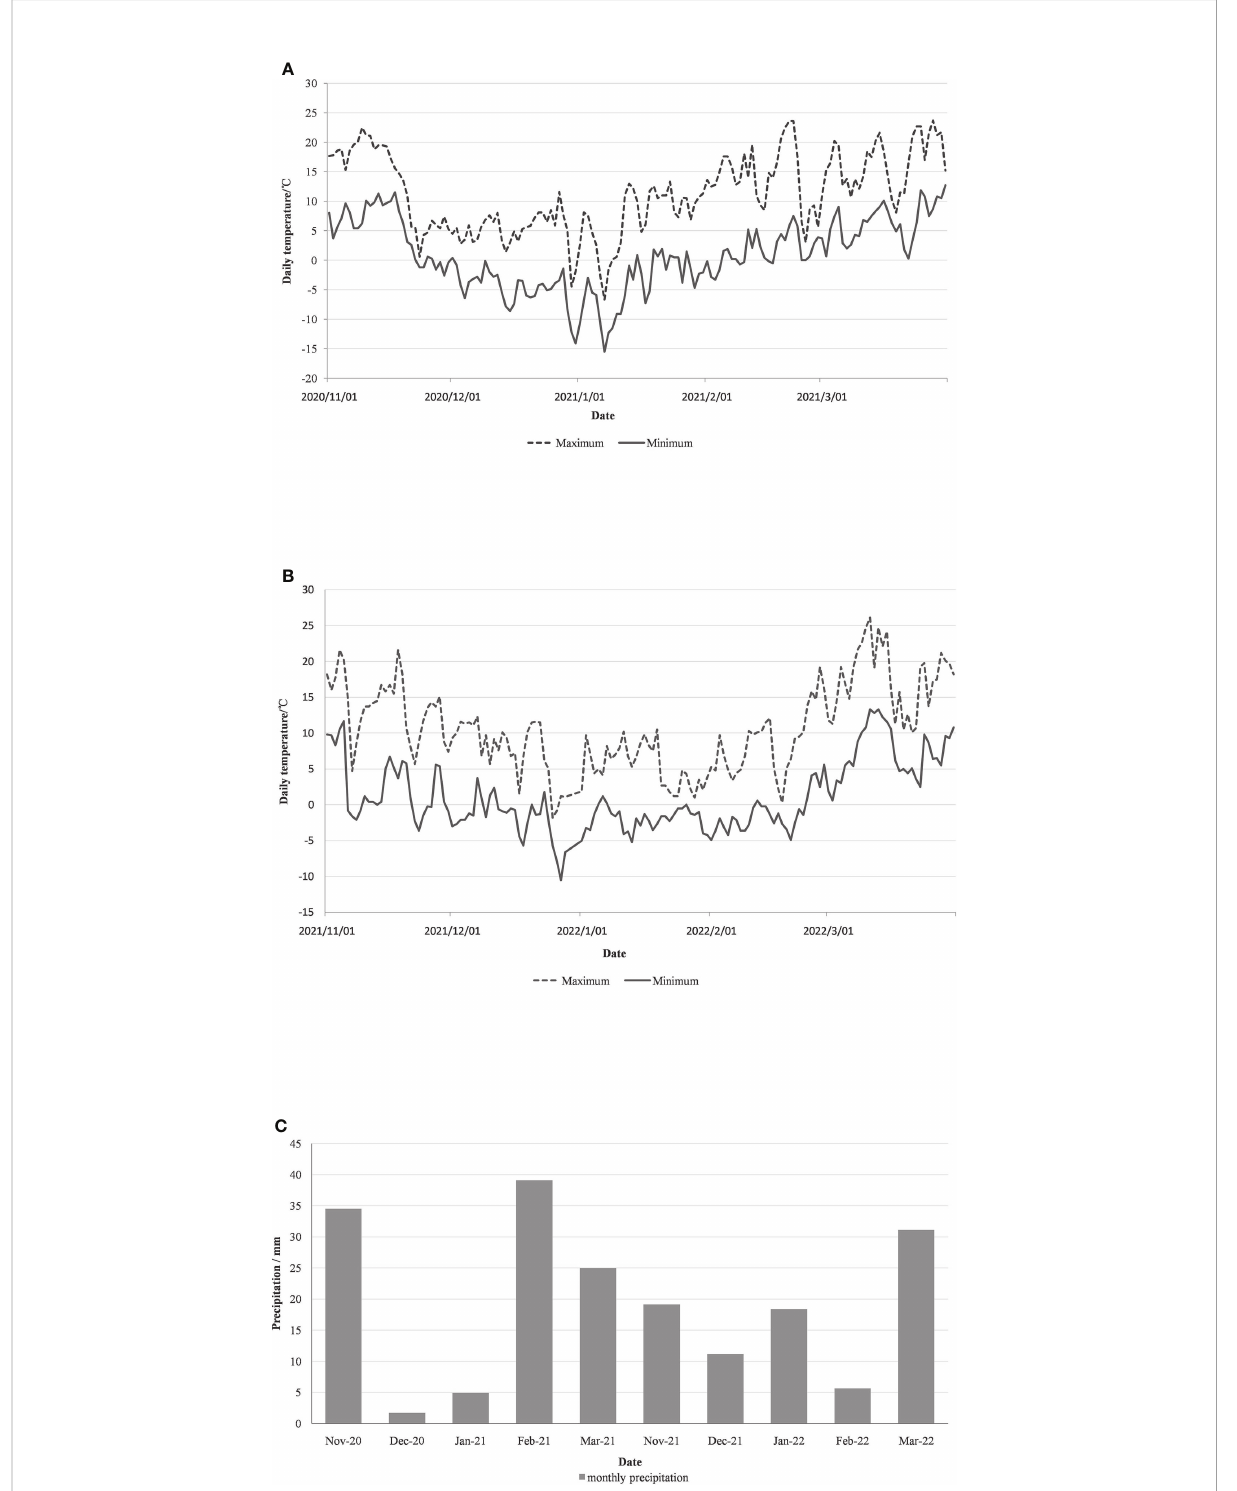
FIGURE 1 Daily maximum temperature, minimum temperature (A, B) and monthly precipitation (C) during the overwintering period (December to March) in 2020 and 2021 in Xia